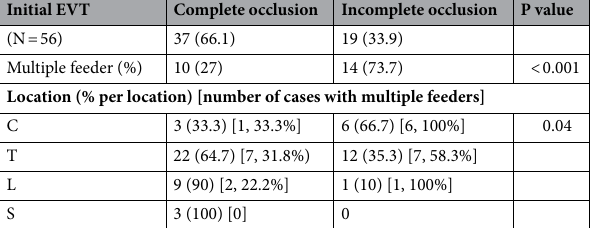
Table 3. Angiographic results after the initial endovascular treatment of 56 patients with spinal dural arteriovenous fistula. Values represent numbers of patients (%). C cervical; T thoracic; L lumbar; S sacral.